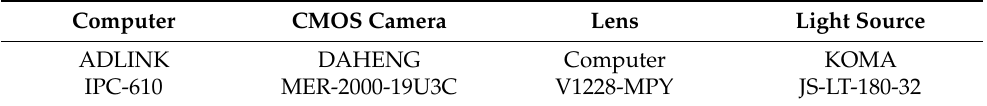
Table 1. Main hardware of the